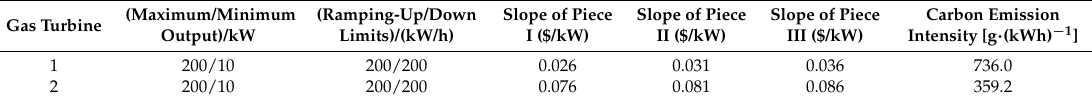
Table A1. Parameters of gas turbines.